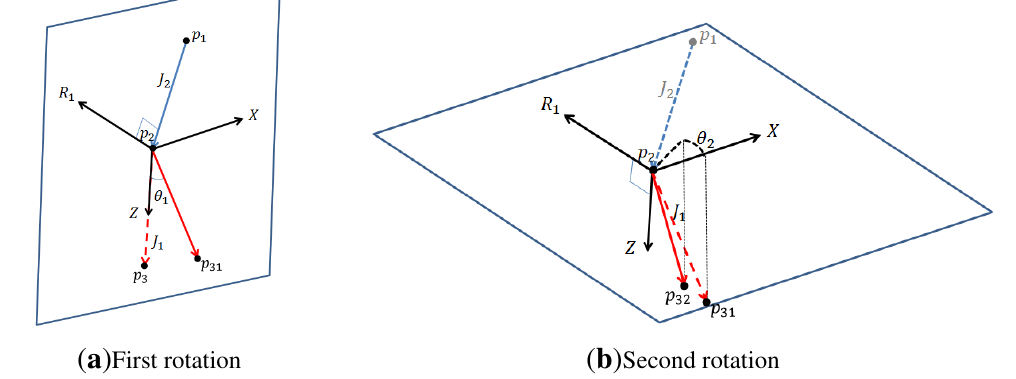
Figure 5. Generation of a new joint angle for a two-DOF joint. The joint, p to p by adding a noise to the joint angle, ∠ p 31 to p by rotating with respect to Z ( b 32